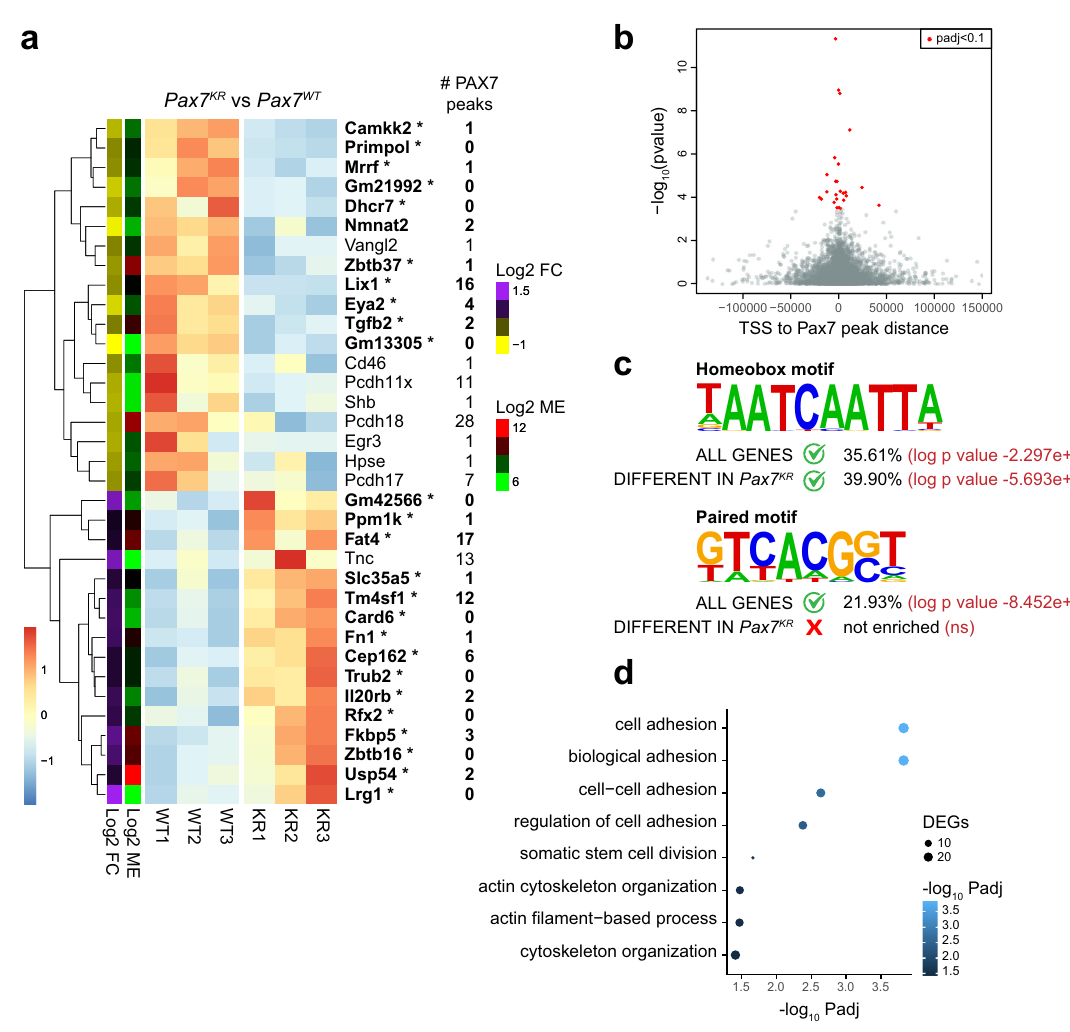
Fig. 8 PAX7 acetylation regulates target gene expression in satellite cells. a Heatmap from normalized expression matrix of differentially expressed genes between Pax7 WT and Pax7 KR satellite cells. The number of PAX7 ChIP-seq peaks associated with each gene is indicated. Genes in bold with an asterisk are signi fi cantly different (Wald test followed by multiple testing correction using the Benjamini – Hochberg method to control the false discovery rate, with application of a cut-off of 0.1 (approximating to a p -value of 3.5 × 10 − 4 ) to corrected values). Heatmap coloring indicates row Z-score; color bars to the left indicate log2 fold change, and log2 mean expression. b Plot illustrating the distance from the closest PAX7 ChIP-seq peak and transcriptional start site (TSS) to the closest PAX7 ChIP-seq peak vs the negative log p -value for all PAX7 target genes. Differentially and signi fi cantly expressed genes between Pax7 WT and Pax7 KR satellite cells are highlighted in red (Wald test followed by multiple testing correction using the Benjamini – Hochberg method to control the false discovery rate, with application of a cut-off of 0.1 (approximating to a p -value of 3.5 × 10 − 4 ) to corrected values). c Motifs identi fi ed de novo in Pax7 peaks are similar to motifs described in Soleimani et al. 10 . The homeobox motif is enriched in PAX7 target genes (all genes), as well as in the subset that is differentially expressed in Pax7 KR satellite cells. In contrast, the paired motif is found only when analyzing peaks associated with all PAX7 target genes, but not when considering only the subset of genes differentially expressed in Pax7 KR satellite cells. Numbers indicate the percentage of peaks containing the different motifs, as well as the p value calculated by HOMER. d Gene ontology (GO) term enrichment analysis (biological process) for PAX7 target genes that are differentially expressed between Pax7 WT and Pax7 KR satellite Methods Animal models . Housing, husbandry, and all experimental protocols for mice used nucleotides indicated in lowercase) was microinjected into C57BL/6J zygotes. in this study were performed in accordance with the guidelines established by the Injected zygotes were incubated in KSOM AA media (Zenith Biotech, ZEKS-50) at University of Ottawa Animal Care Committee, which is based on the guidelines of the Canadian Council on Animal Care. Protocols were approved by the Animal Research Ethics Board of the University of Ottawa. Six to eight-week-old mice were DNA isolation and genotyping (Supplementary Table 1). Founders were crossed used for all the experiments, except for those performed in aged mice (more than with WT C57BL/6J mice. F1 heterozygous mice were interbred to generate F2 21 months). The Myf5-Cre:R26R-EYFP mice were F1 progeny from Myf5-Cre and homozygous mice and WT littermates used as controls. R26R-EYF crossing 25 . Pax7 KR mice were generated by direct delivery of Cas9 reagents to C57BL/6J mouse (The Jackson Laboratory, #000664) zygotes essentially as described in ref. 58 at The Centre for Phenogenomics (Toronto, ON, Canada). Cell Lines . C2C12 cells were used for co-immunoprecipitation and ChIP experi- Brie fl y, the gRNA was designed by identifying the PAM nearest to the desired mutation site. Speci fi city of the gRNA was evaluated using the online tool available ments, COS-7 cells were used for luciferase assays, and Sf9 cells were used to at crispr.mit.edu. The gRNA with the desired spacer sequence (Supplementary produce PAX7 protein for EMSAs. C2C12, COS-7, and Sf9 cells were purchased Table 1) was synthesized by in vitro transcription from a PCR-derived template. from and authenticated by ATCC. These cells were not contaminated by